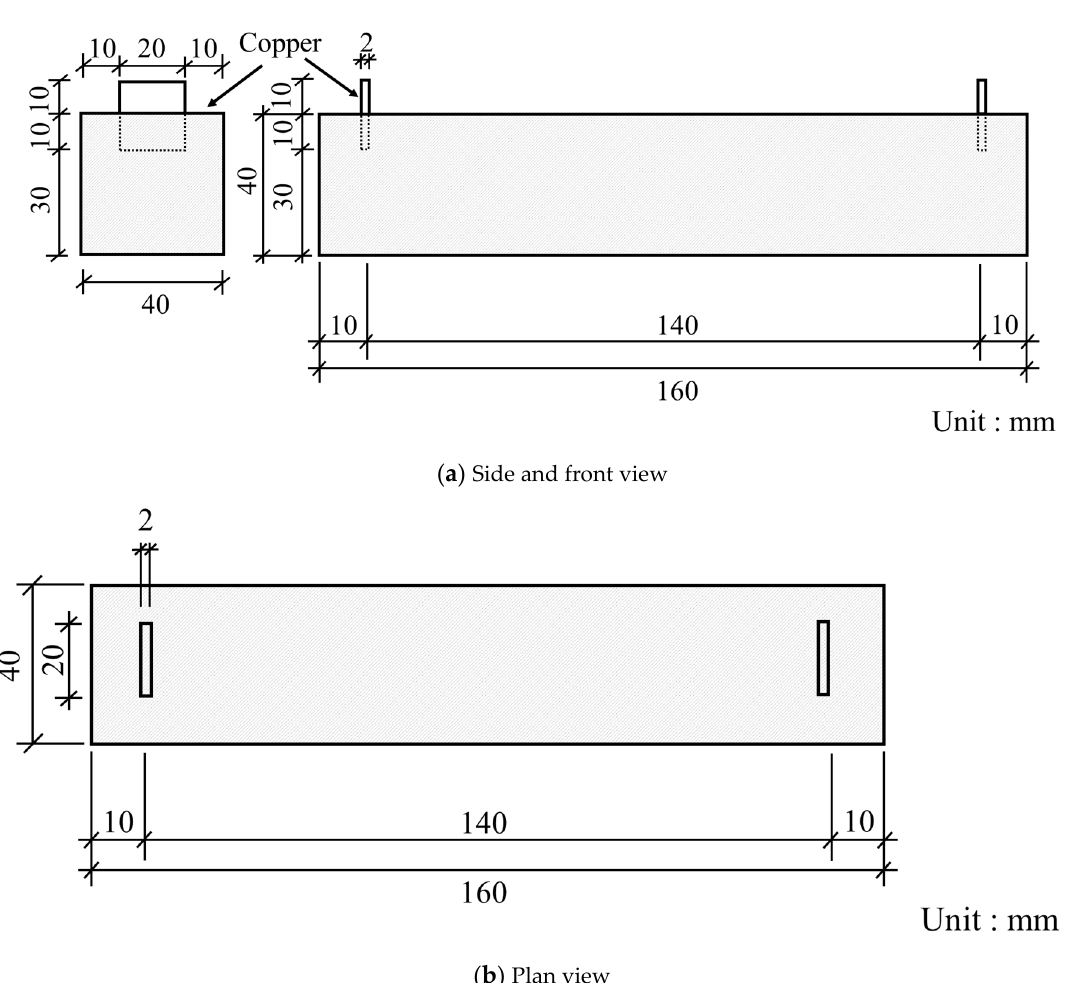
Figure 3. Dimension of rectangular parallelepiped specimen of cement mortar for electrical resistance test: ( a ) side view and front view; ( b ) plan view.